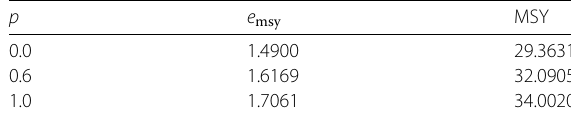
Table 10 The values of the maximum sustainable yield (MSY) and maximum effort ( e msy ) for different values of the parameter p when both the prey species x and middle predator y are harvested from the system p e msy